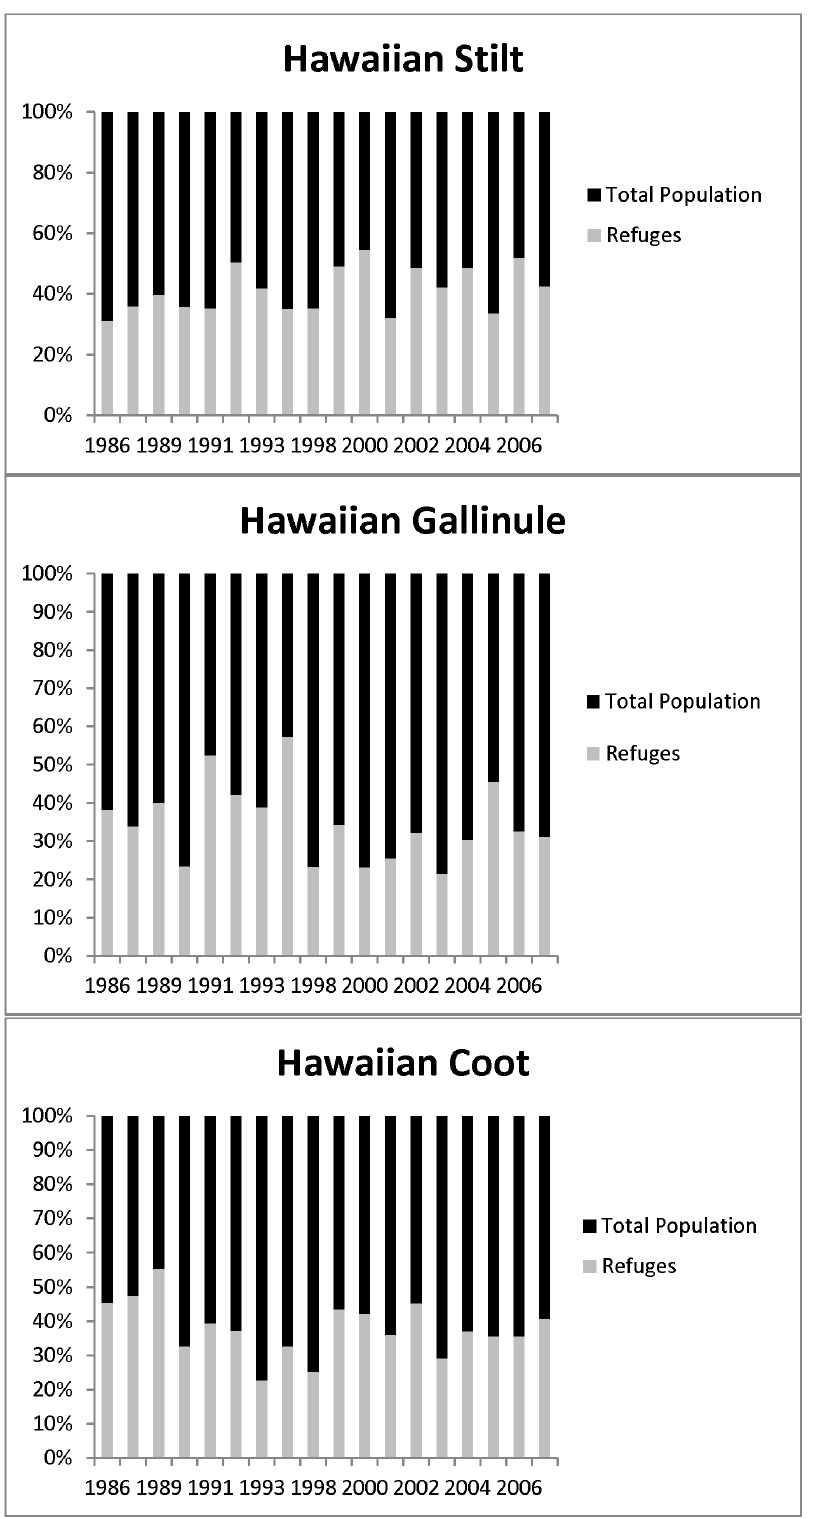
Figure 2. Percentage of endangered waterbird populations counted on six national wildlife refuges in Hawai’i, USA for the time period spanning 1986–2007. Refuges account for only 15% of available wetland habitat.